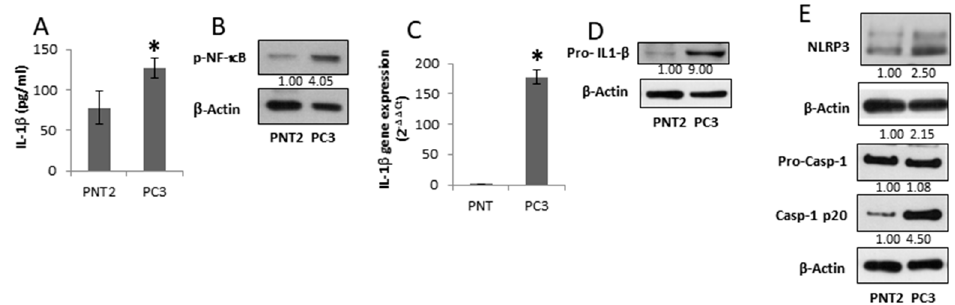
Figure 2. IL-1 β -secreting PC3 cells contain an active NLRP3-inflammasome cascade. Normal prostate PNT2 and prostate cancer PC3 cells were grown for 48 h, and ( A ) IL-1 β in the supernatant was assessed by ELISA. Results are reported as mean ± S.D. n = 5 separate experiments. * p < 0.05 vs. PNT2 cells; ( B ) p-NF- κ B (p65) expression was evaluated in total cell extract analyzed by Western blotting. B-actin was used as a loading control. The images are representative of one out of n = 3 separate experiments; ( C ) IL-1 β gene expression was assessed by qRT-PCR. Gene expression values were normalized to HPRT and presented as 2 − ∆∆ Ct . Relative mRNA gene abundance in PNT2 cells was assumed as 1. Data represent mean ± SD ( n = 5). * p < 0.05 vs. PNT2 cells; ( D ) pro-IL-1 β , and ( E ) NLRP3, caspase-1 full length and mature caspase-1-p20 expression was evaluated in total extract analyzed by Western blotting. β -actin was used as a loading control. The images are representative of one out of n = 3 separate experiments. Numbers below the images represent the ratio between the respective protein and β -actin band intensity.